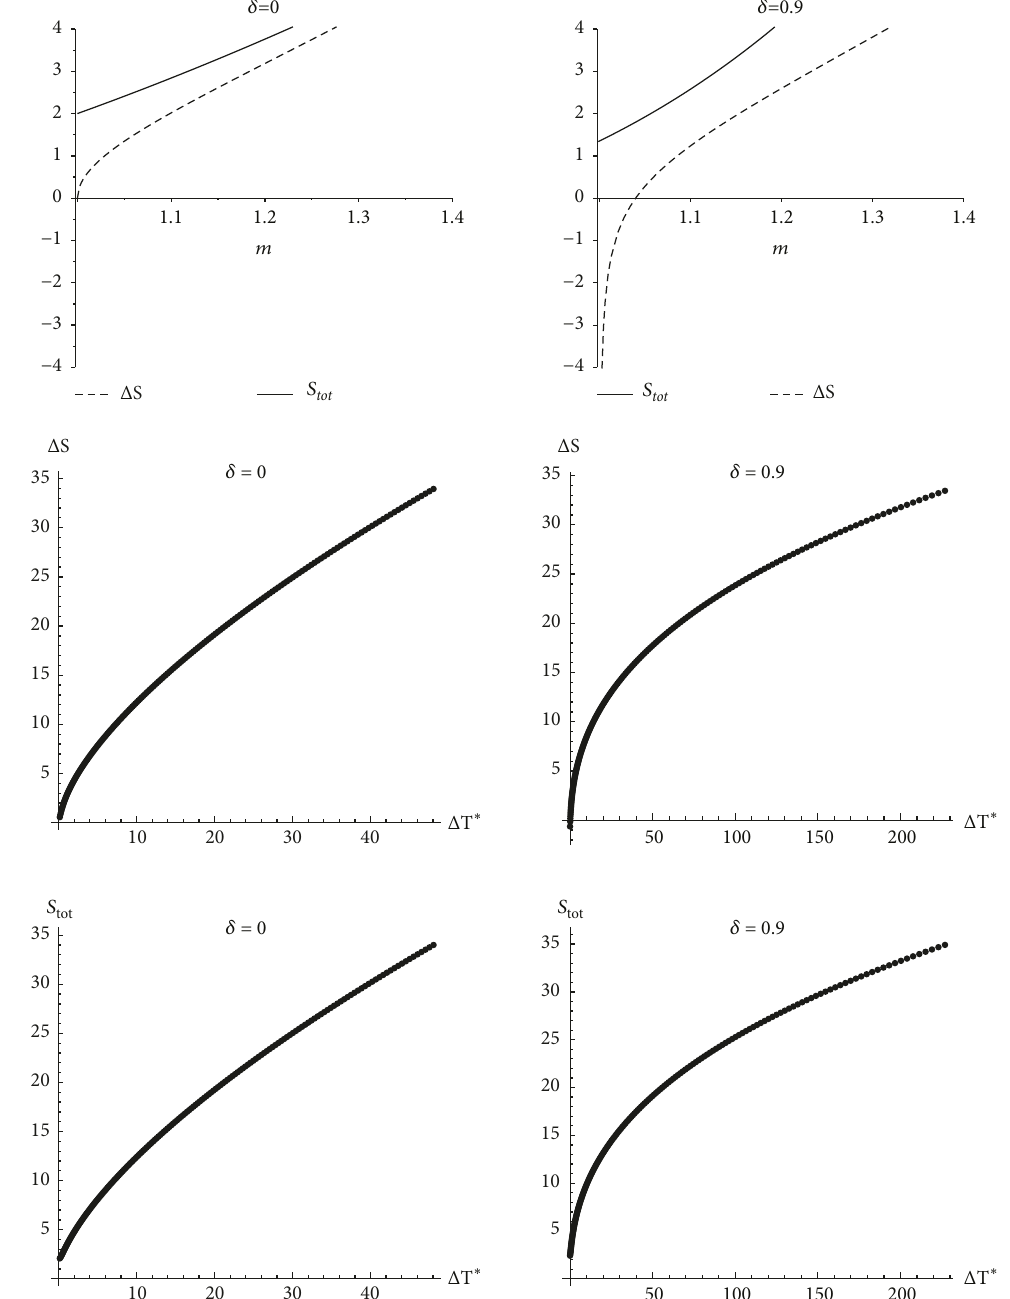
Figure 3: Diagram of Δ𝑆 and 𝑆 𝑡𝑜𝑡 is plotted against 𝑚 and Δ𝑇 ∗ for 𝛿 = 0 and 𝛿 = 0.9 .